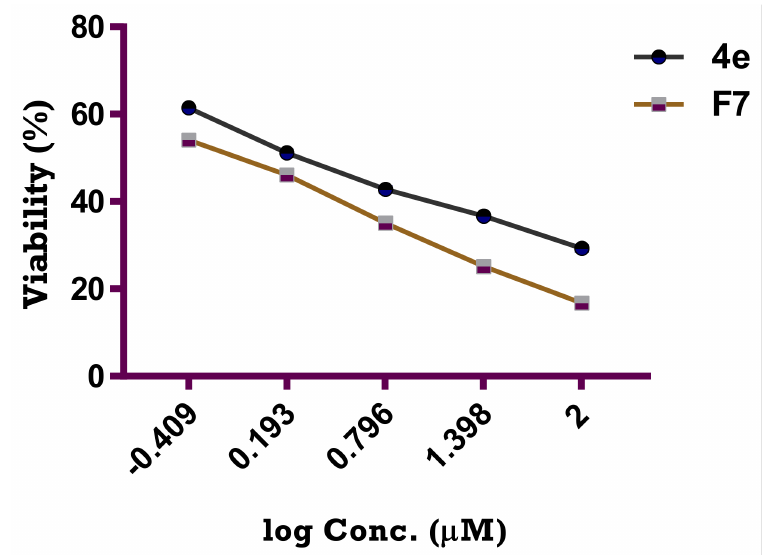
Figure 16. Graphical representation for comparison showing the effect of compounds 4e and 4e - loaded in PEGylated bilosomal formula ( F7 ) at varying concentrations ( µ M) on MCF-7 cell